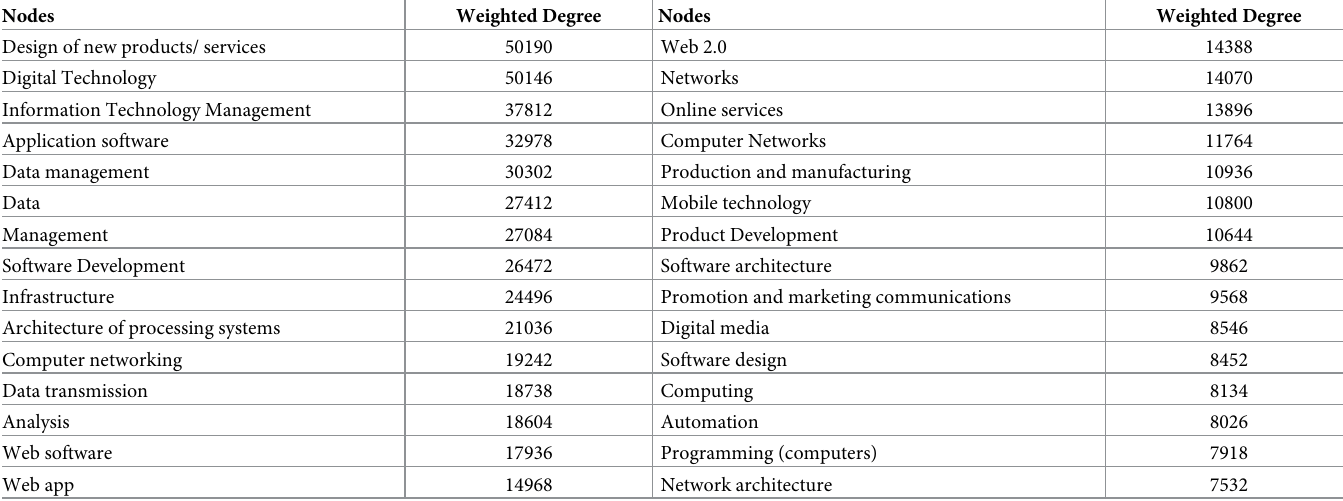
Table 10. Top 30 specializations based on the co-occurrence of competencies (weighted degree).